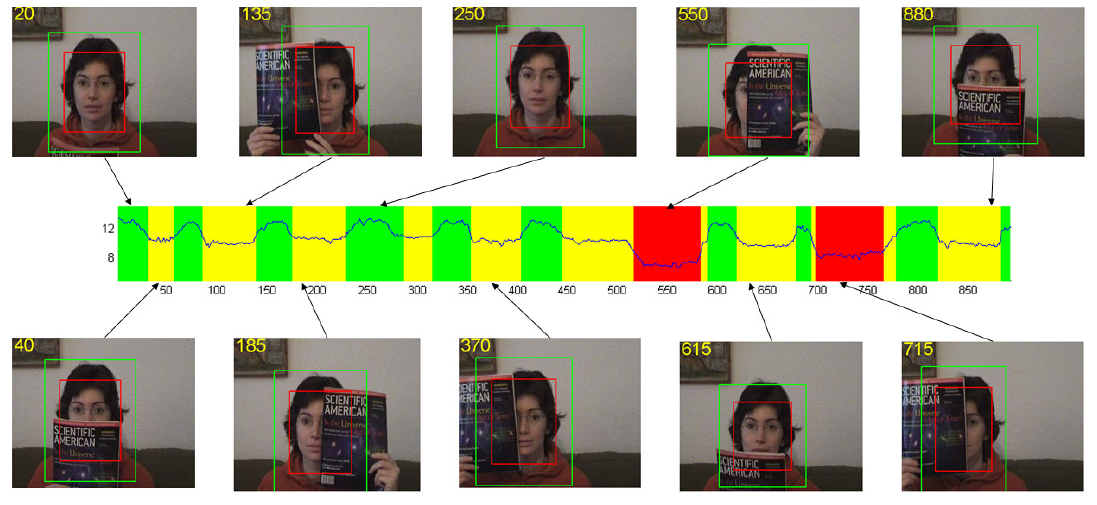
Figure 3. PSR (peak-to-sidelobe rate) plot, where the curve plots the PSR of every frame in faceocc1 sequence. The area enclosed by the red rectangle is the target area, and the one enclosed by the green rectangle is the whole candidate